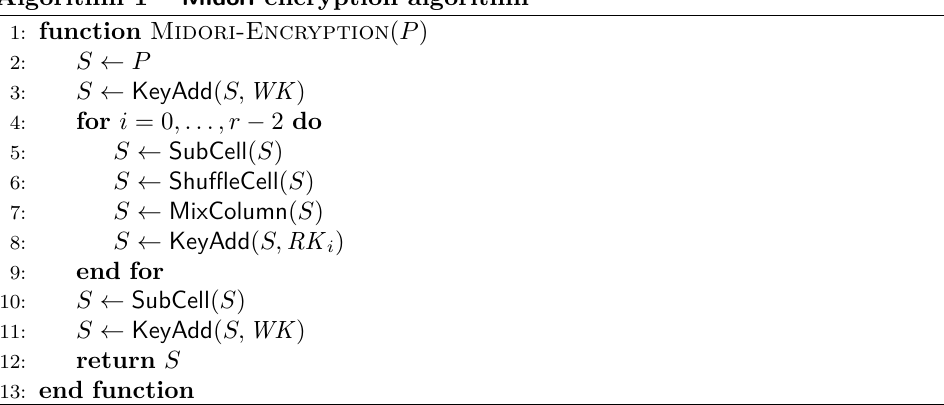
Algorithm 1 – Midori encryption